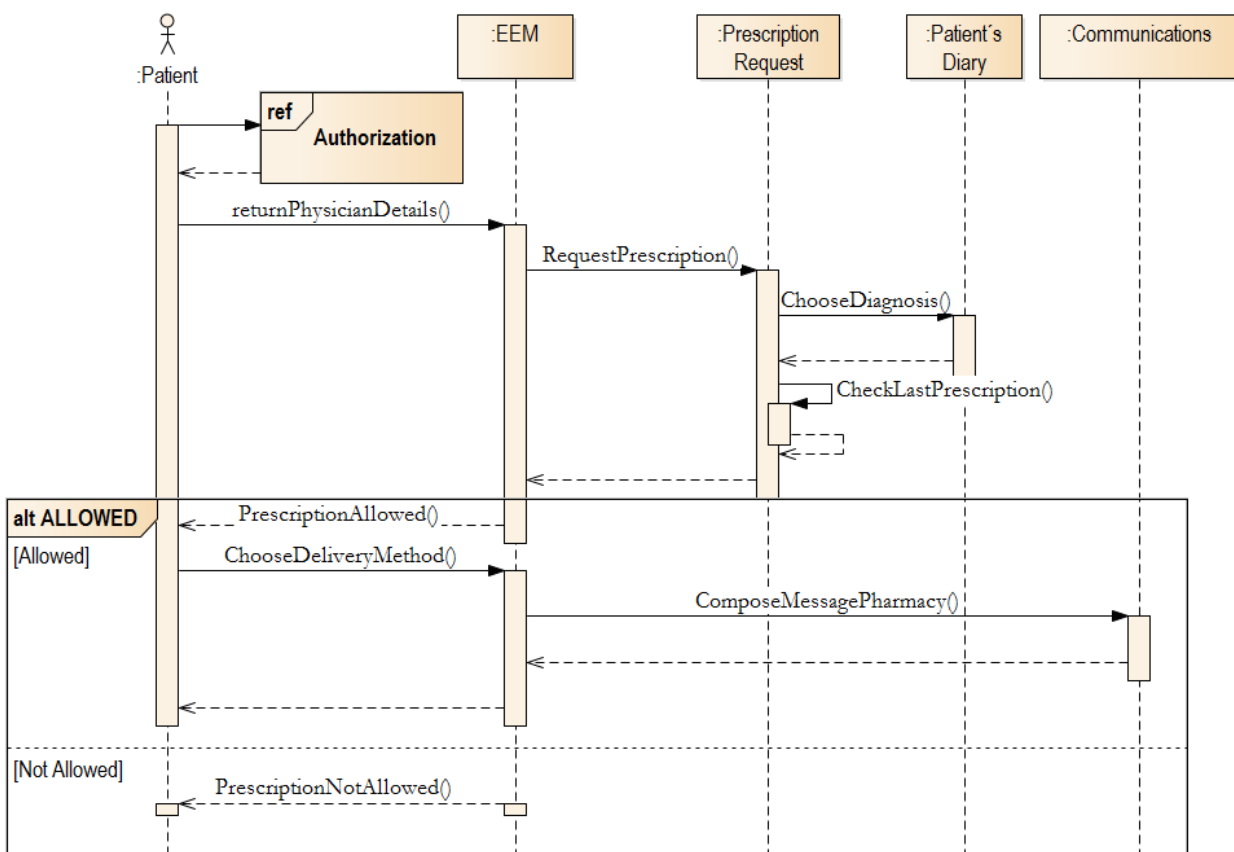
Figure 5. Prescription request